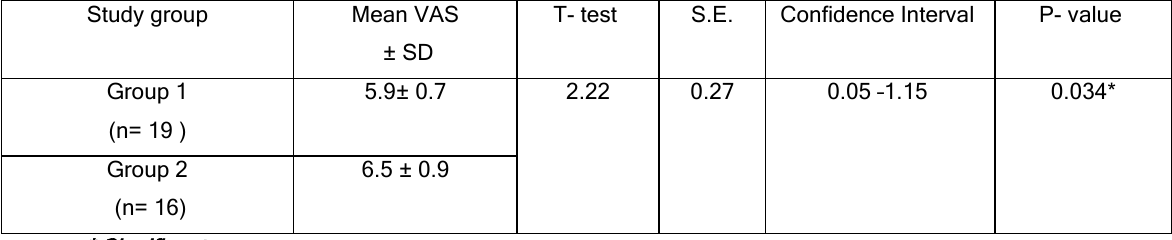
Table (4): A comparison between study groups in current study regarding VAS after 6 months of operation.